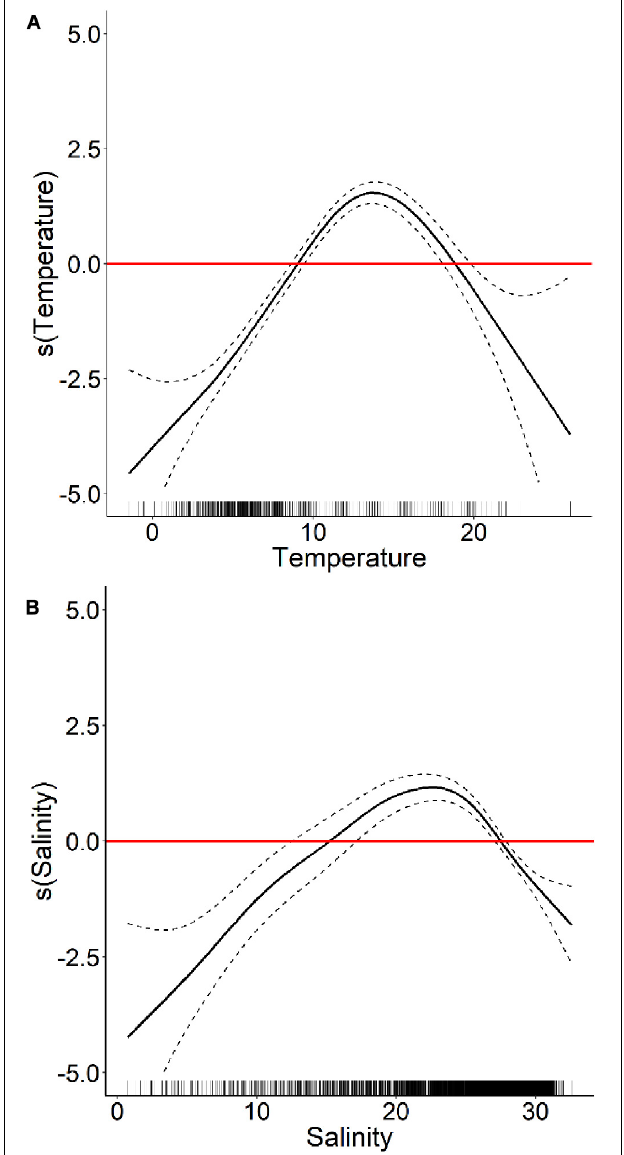
FIGURE 2 | Generalized additive mixed model partial response curves (black line) ± standard deviation (black dashed line) showing the influence of (A) sea surface temperature and (B) sea surface salinity on Alexandrium catenella occurrence (bloom events ≥ 1000 A. catenella cells L − 1 ) in the Estuary and Gulf of St. Lawrence. The red line indicates a neutral influence of the predictor variable on the presence of A. catenella .